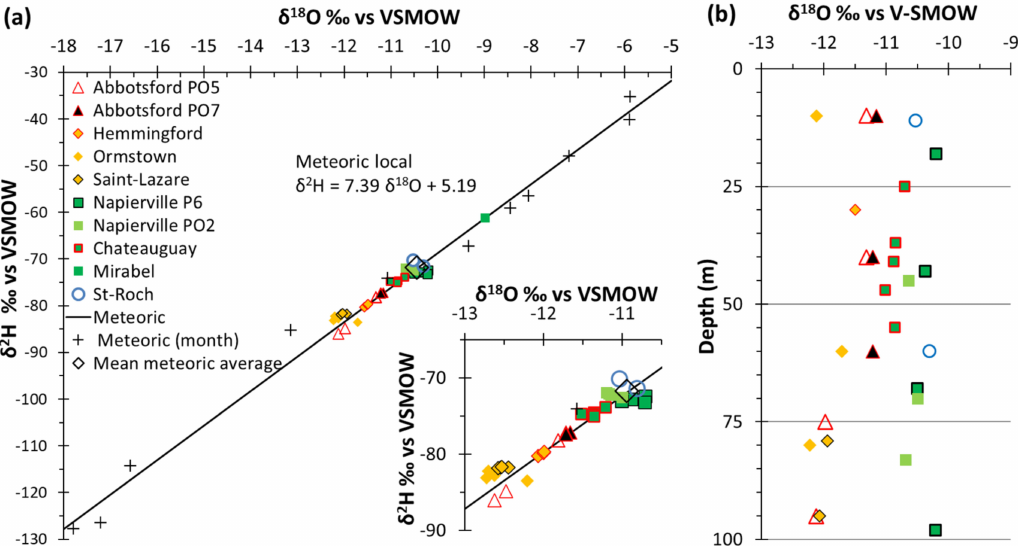
Figure 15. ( a ) δ 18 O and δ 2 H compositions in groundwater and in local precipitation. ( b ) δ 18 O composition with the